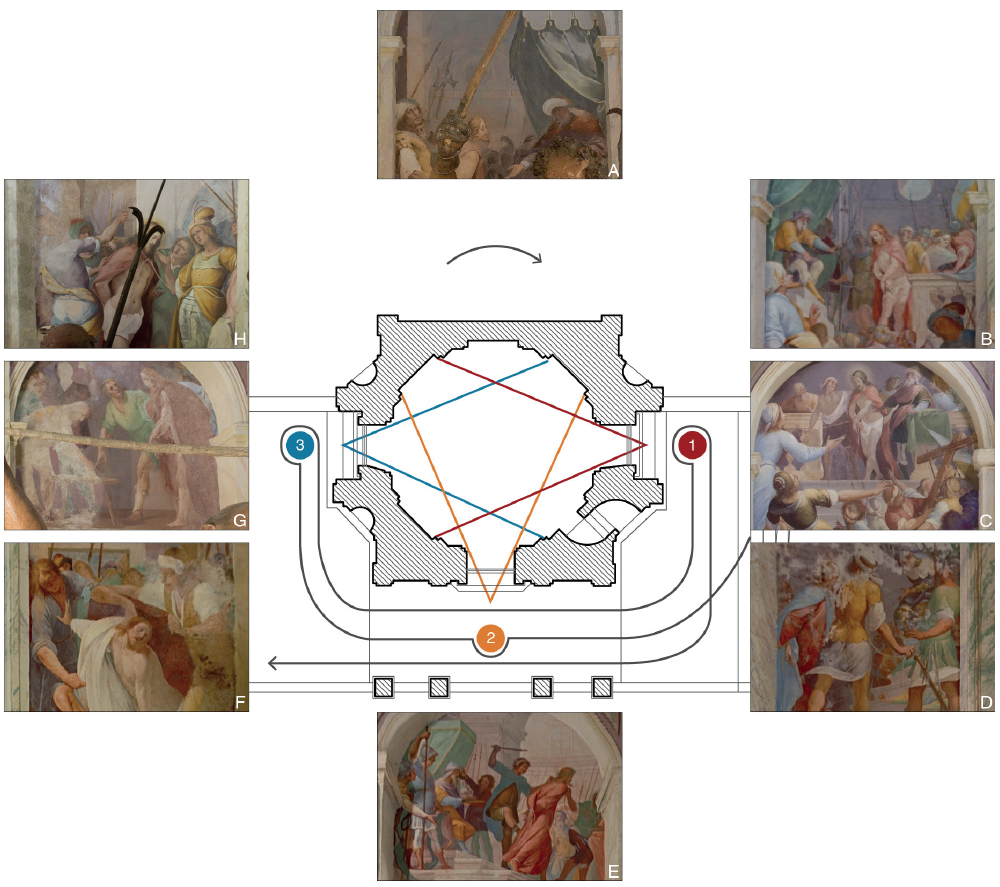
Fig. 9 Corsini’s hypothesis of the path for contemplation of the internal